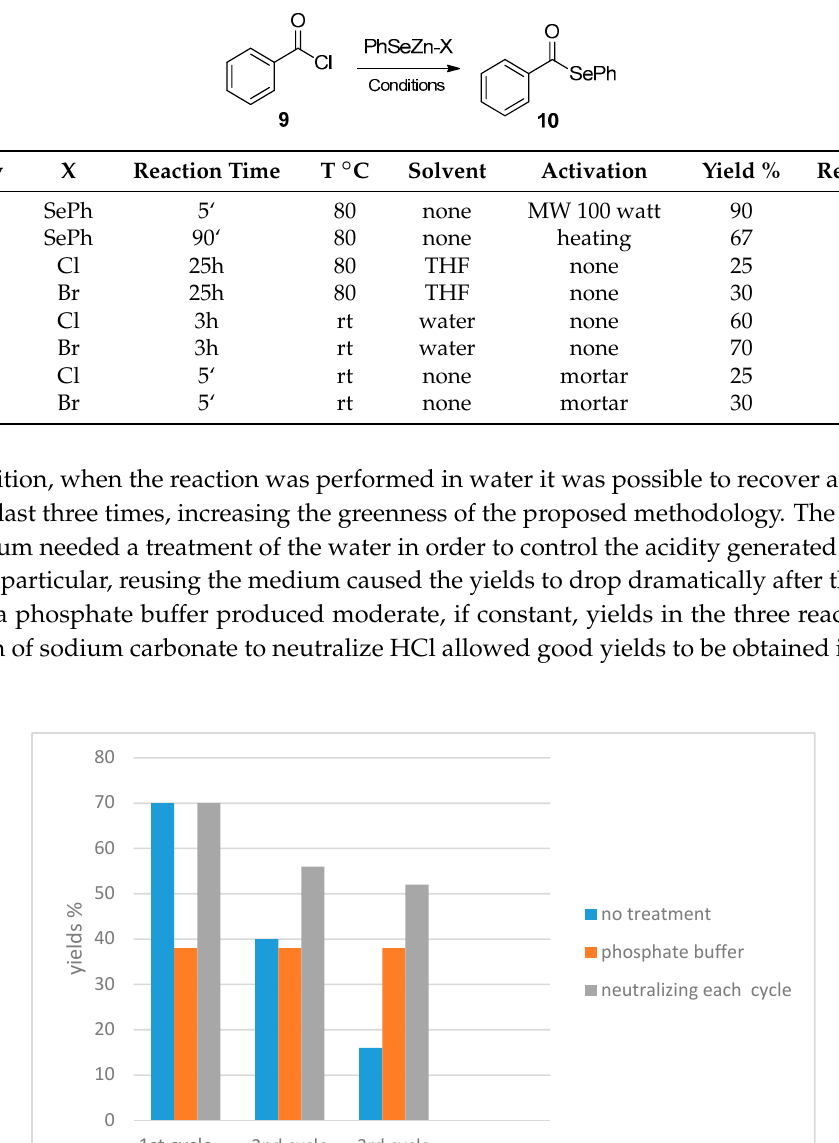
Table 2. Acyl substitution for the synthesis of selenoesters.